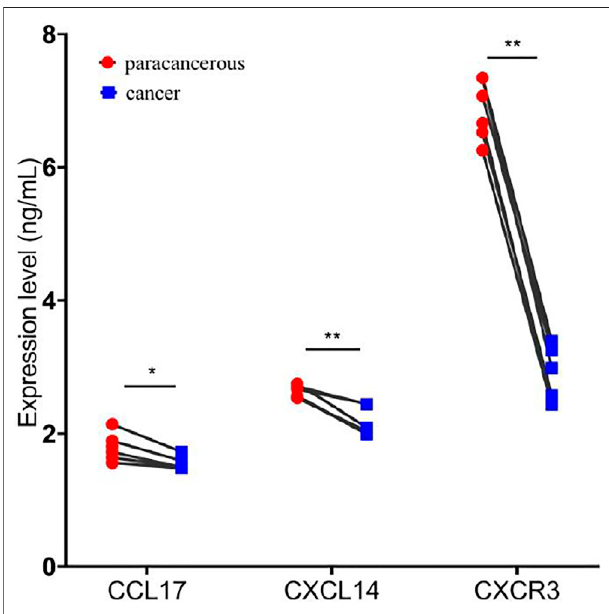
FIGURE 7 | Overexpression of SLC7A11 inhibits the expression of chemokines and chemokine receptors. n = 6, * p < 0.05, and ** p < 0.01.